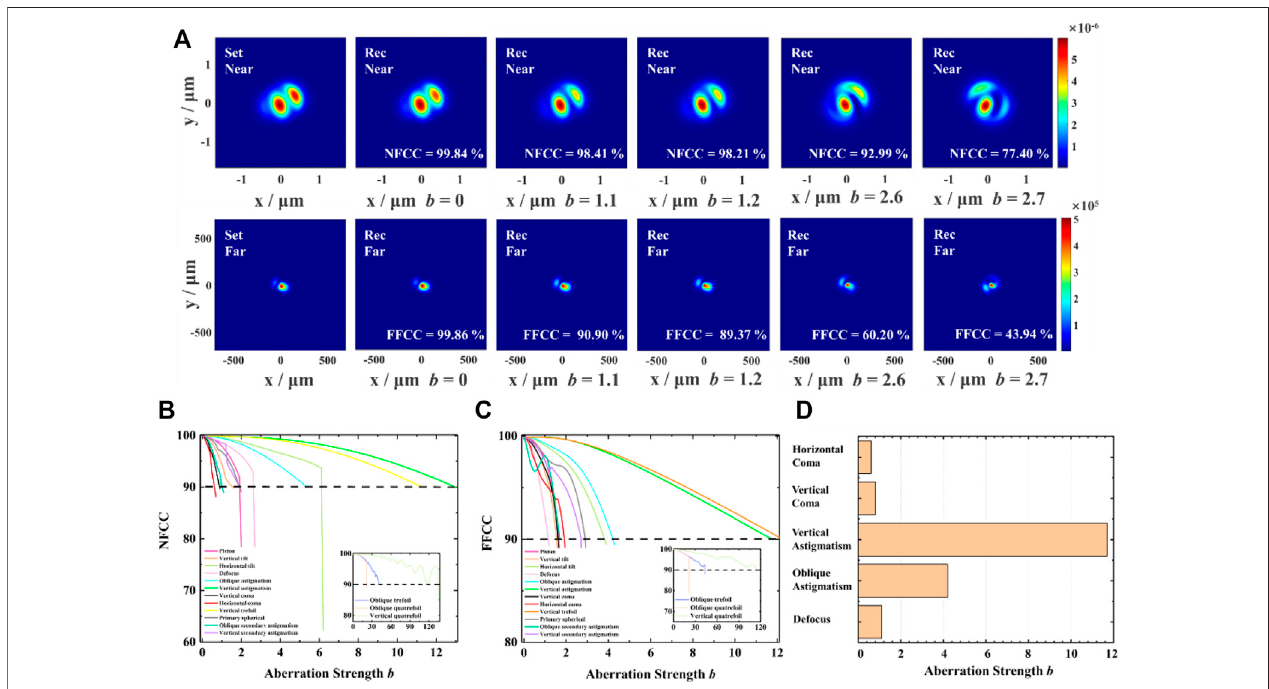
FIGURE 4 | (A) Comparison of the set near/far optical fi eld and reconstructed near/far optical fi eld under various defocus aberration strengths. The curve of (B) NFCC and (C) FFCC withtheaberration strength ofthe fi rst fi fteen Zernike terms. (D) Thetolerance ofmodal decomposition (MD) to fi vekindsofaberrations.AvalidMD has large tolerance to vertical astigmatism and oblique astigmatism and is strongly deteriorated by horizontal coma, vertical coma, and defocus. Set Near/Far, set near/ faroptical fi eldintensity; RecNear/Far,reconstructed near/faroptical fi eldintensity; NFCC,near- fi eldcross-correlationcoef fi cient;FFCC, far- fi eldcross-correlation coef fi